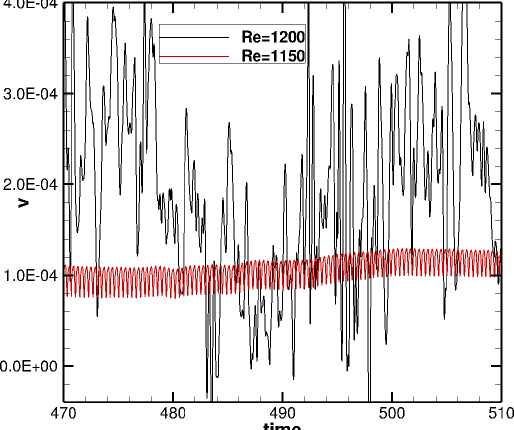
Figure 6. Wavy wall channel flow: vertical velocity at a tracer point at z = − 0.935 at Re = 1150 and